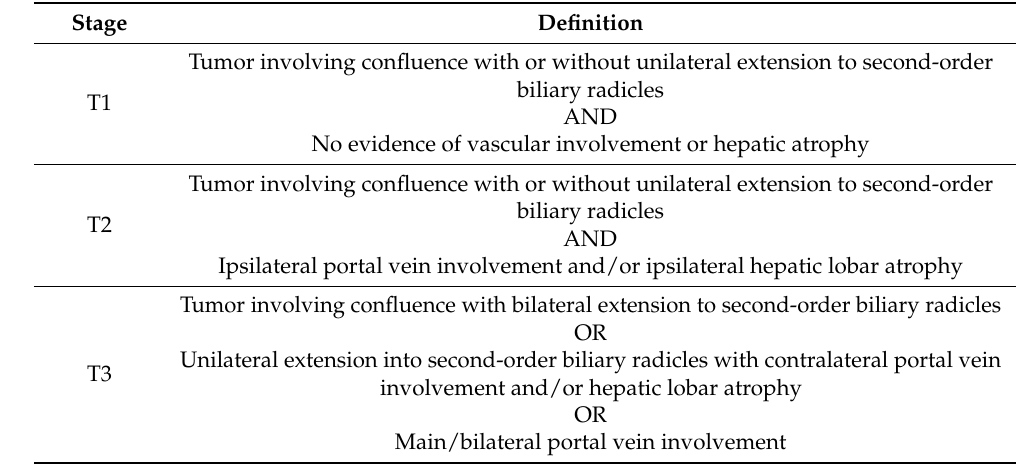
Table 1. Perihilar Cholangiocarcinoma Blumgart T Stage